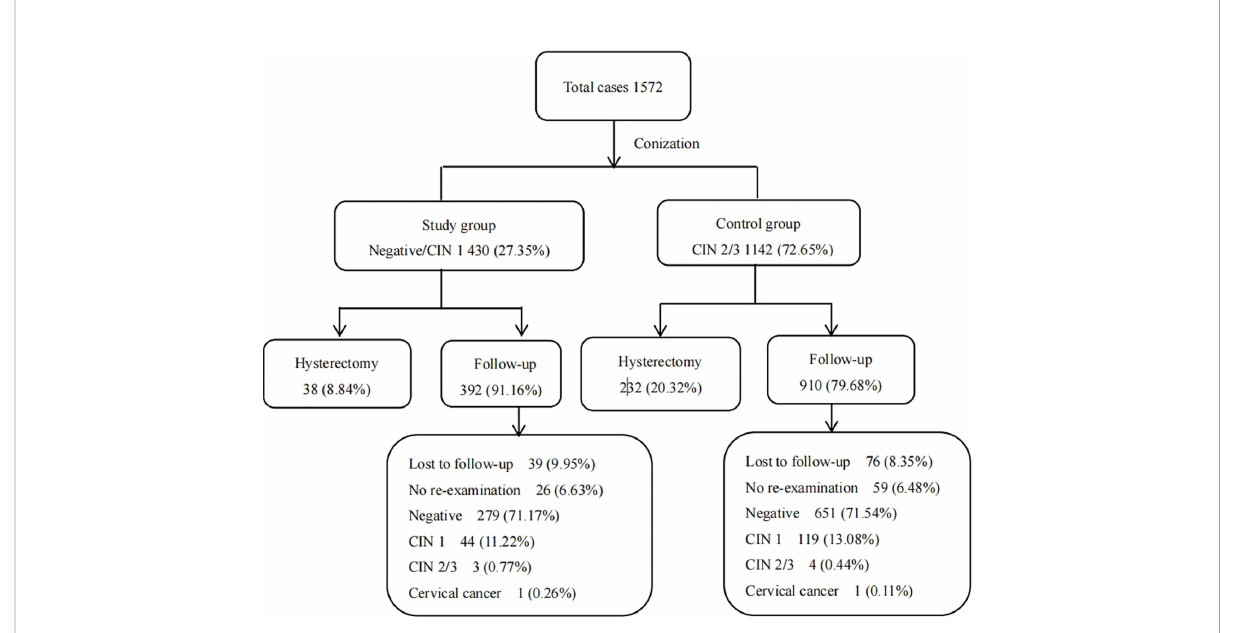
FIGURE 1 Results of diagnosis and follow-up for 1572